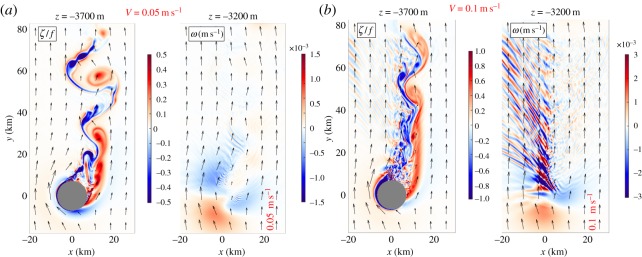
Snapshots of ζ(x,y)/f and w(x,y) at the indicated heights in simulated flow past a 600 m high seamount (the grey discs at z=−3700 m) above the sea-floor at z=−4000 m with a half-height diameter of 15 km. The solutions differ only in the speed of the incoming, horizontally uniform, barotropic flow, V0=0.05 (a) and 0.1 m s−1 (b). The former is firmly within a vortical wake regime, while the latter shows mixed vortical wake and lee IGW generation. Notice the doubled colour bar ranges with doubled V0 [61].